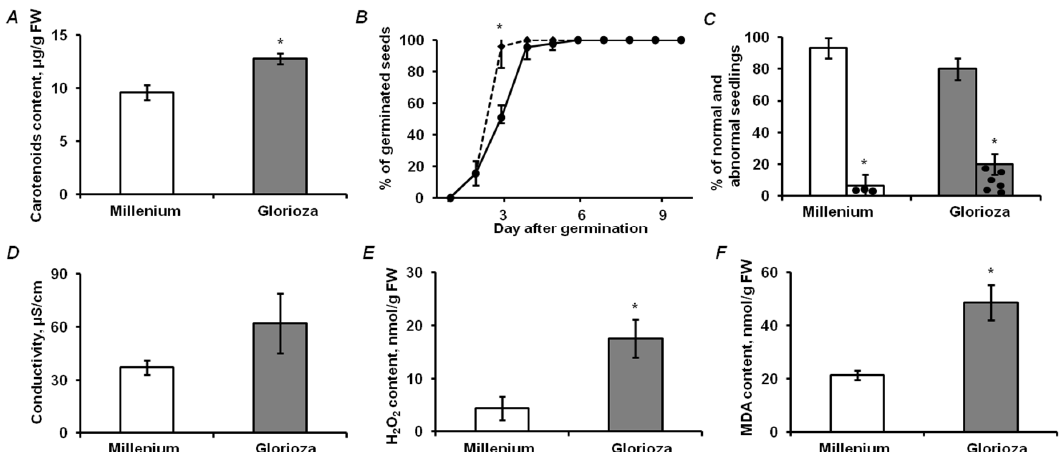
Figure 1. Physiological and biochemical parameters of seed quality, acquired for the mature seeds of cultivar Millennium (solid line, white columns) and Gloriosa (dashed line, grey columns): ( A ) contents of carotenoids, ( B ) kinetics of germination, ( C ) distribution of seedlings by morphology (filled and dotted columns indicate normally and abnormally developed seedlings, respectively), ( D ) electrolyte leakage, expressed as medium conductivity, µ S/cm, as well as ( E ) tissue levels of hydrogen peroxide and ( F ) lipid peroxidation products, expressed as malondialdehyde (MDA) equivalents. Asterisks denote statistically significant difference between cultivars ( A , B , E , F ) or indicate difference between percentage of nongerminated seeds in two cultivars ( C ), t -test: p < 0.05.